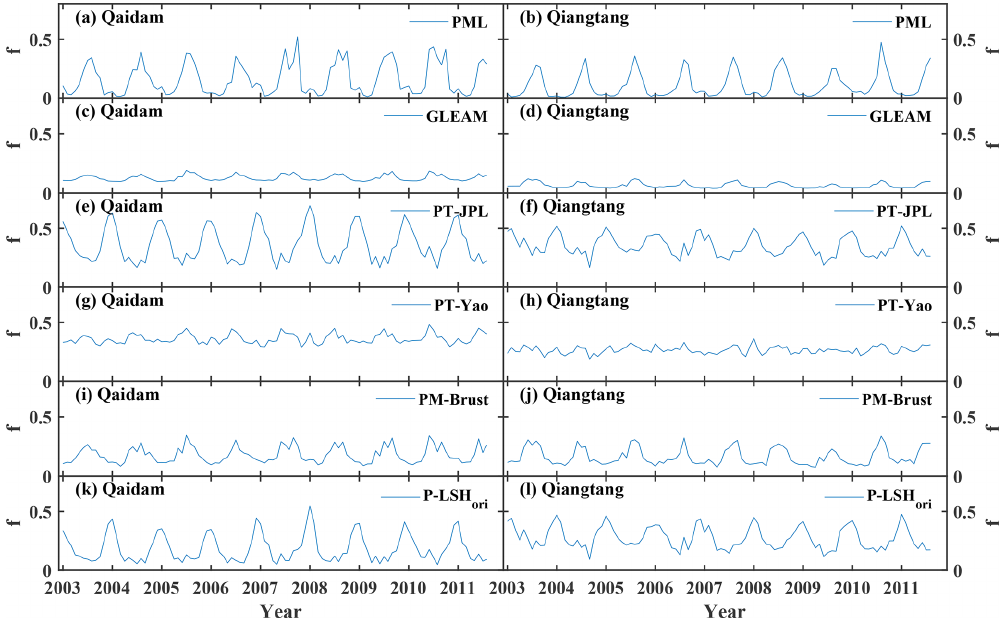
Figure 5. The monthly average f derived from the six existing soil evaporation algorithms for the Qaidam Basin and the Qiangtang Plateau.